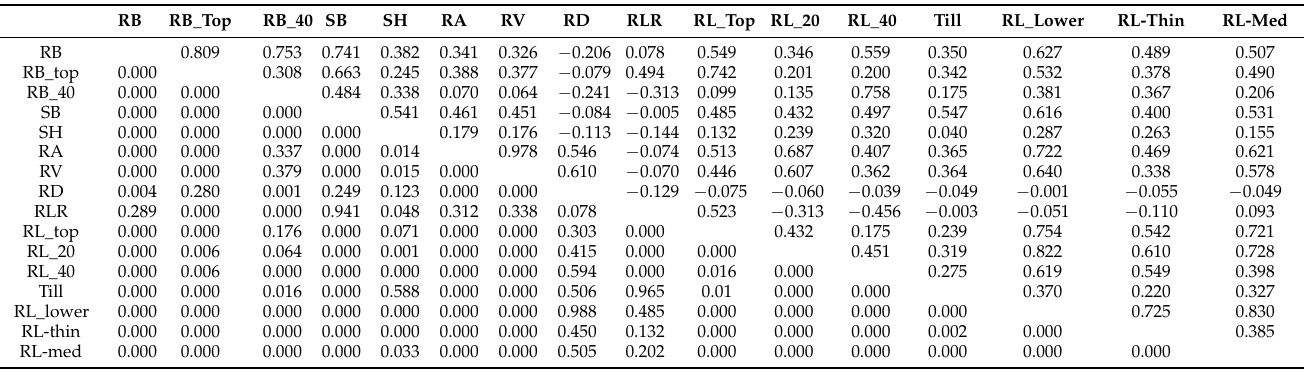
Table 3. Pearson’s correlation matric for 13 root traits and 3 shoot traits in 189 barley genotypes grown in the semi- hydroponic phenotyping system for 30 days after transplanting in a temperature-controlled